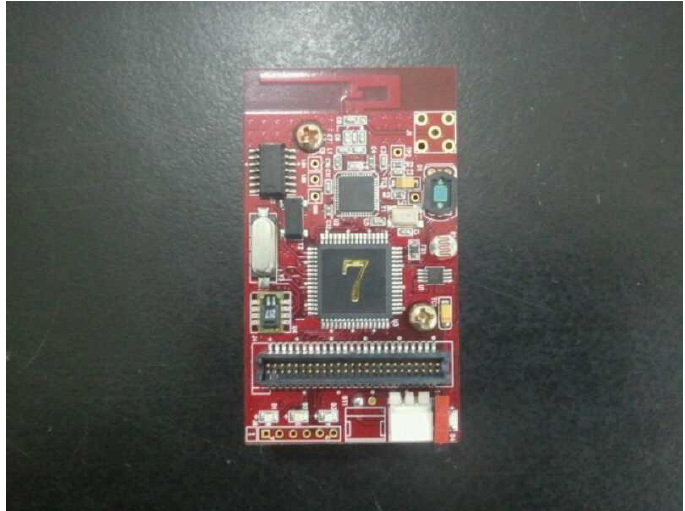
Figure 2. ZigbeX 2.0 sensor node from Hanback